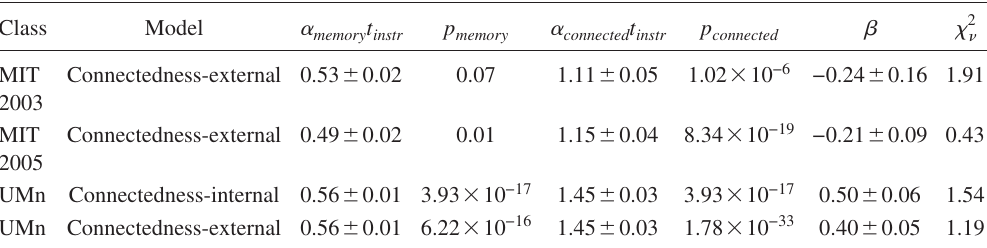
TABLE I. Fit of models to three data sets described in text. Pure memory and simple connected-external models were first fit to determine the products (cid:1) memory t instr and (cid:1) connected t instr . The probability that the data are consistent with each of the pure models is shown as p memory and p connected , respectively. Then, the interpola- tion parameter (cid:4) was varied to produce the lowest reduced chi-squared, (cid:8) (cid:9) 2